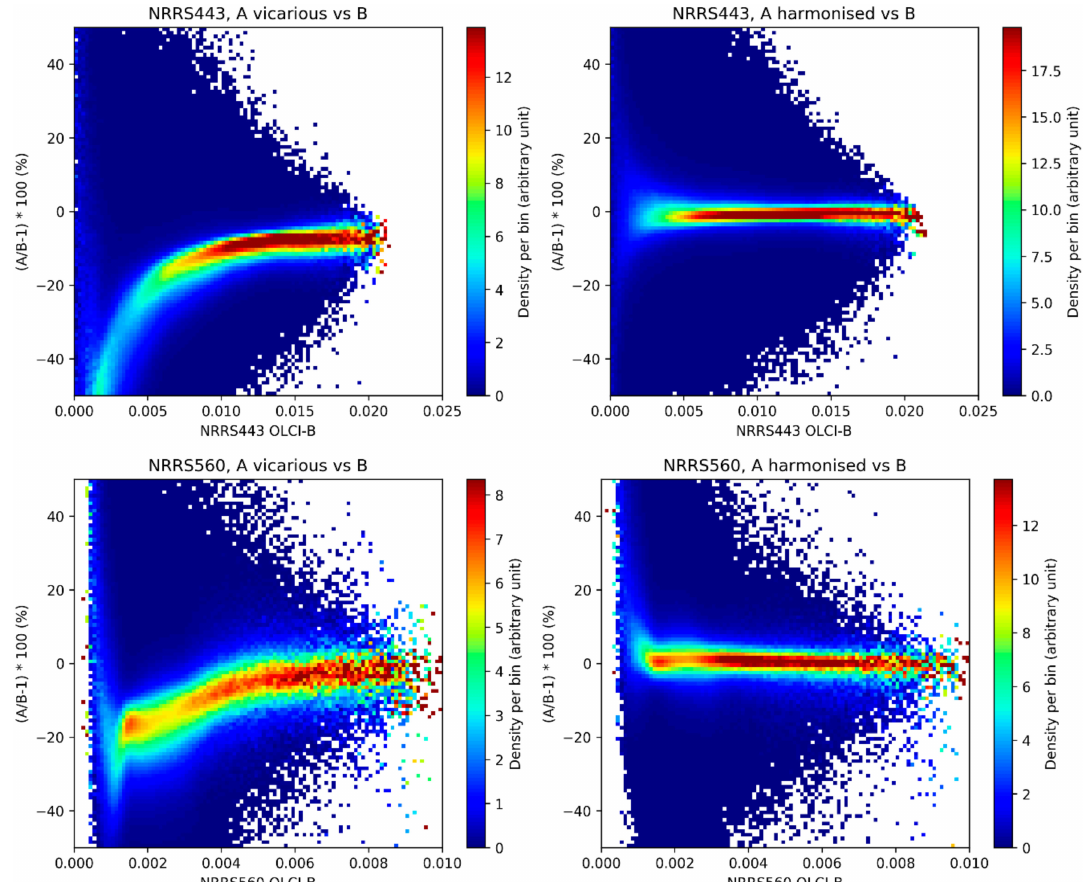
Figure 17. Normalised remote-sensing reflectance (Oa03, 443 nm, top ; Oa06, 560 nm, bottom ) relative di ff erences between OLCI-A (baseline, left ; harmonised, right ) and OLCI-B from all L3 composites over the tandem period. Results are shown as histograms per bin of the corresponding parameter with OLCI-B taken as reference.